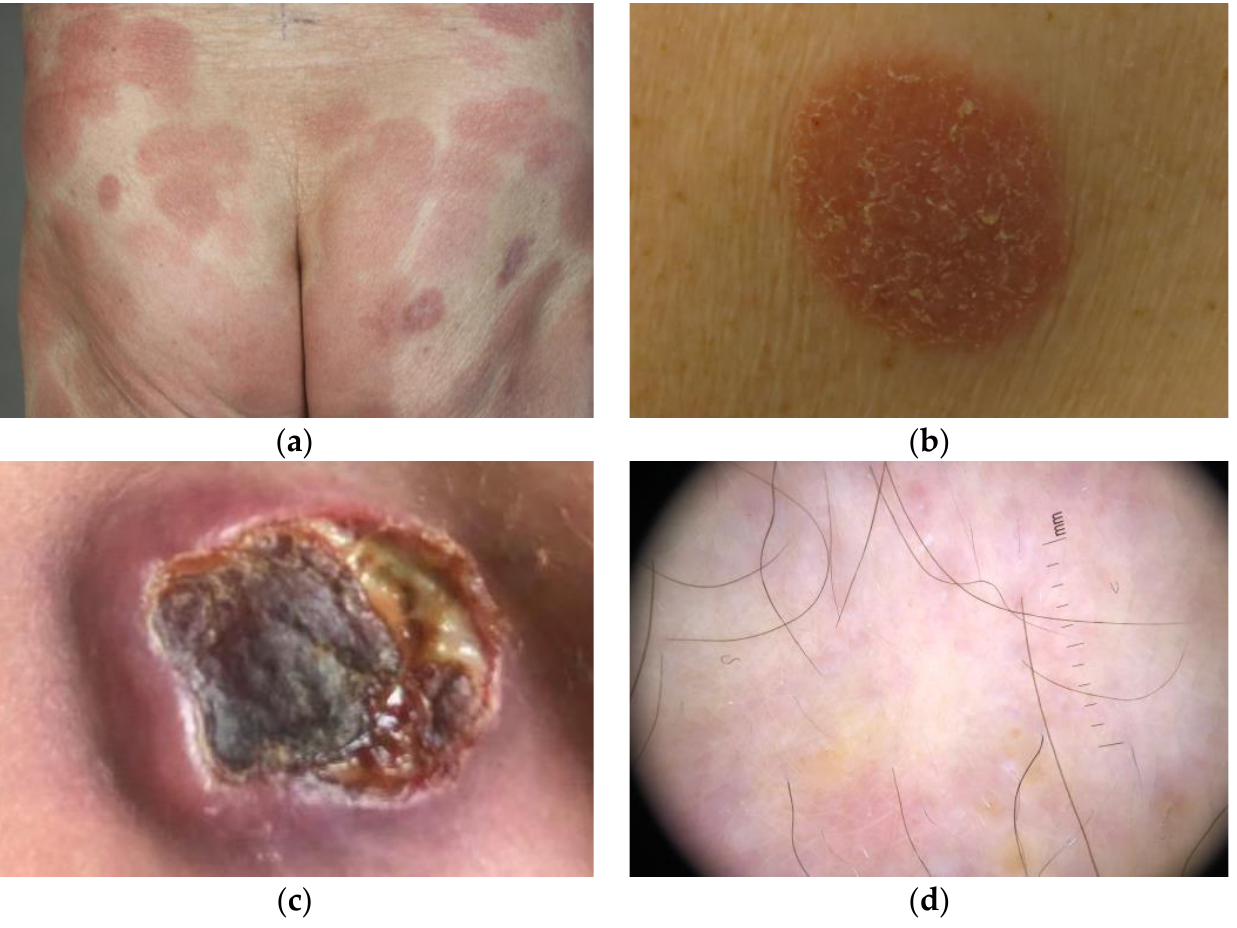
Figure 1. Skin manifestations of mycosis fungoides photographed in some of the study participants. ( a ) Erythematous patches, ( b ) plaque, ( c ) tumor with ulceration, and ( d ) dermoscopy image with orange-yellowish patches.